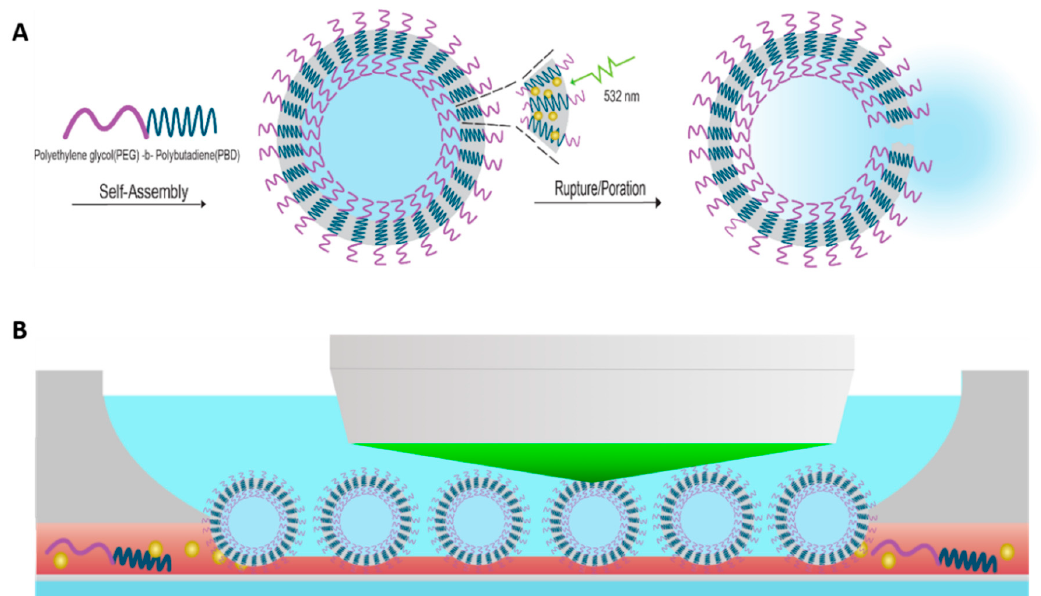
Figure 1. ( A ) Schematic representation of hydrophobic, 2.5 nm, plasmonic gold nanoparticles (AuNPs) incorporated into the hydrophobic membrane of micron-scale polyethylene oxide- b -polybutadiene (PBD 35 -b-PEO 20 ) polymersomes during the self-assembly process. Single-pulse irradiation on resonance with the localized surface plasmon resonance (LSPR) of the AuNPs results in polymersome rupture or poration. ( B ) Irradiation studies are performed at the single-vesicle level, by focusing the laser through an optical objective which allows for irradiation and subsequent imaging.